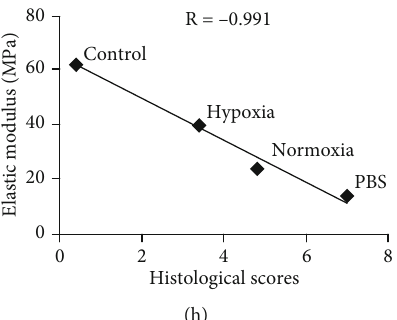
Figure 7: Ultrastructure and biomechanical analysis of specimen at 4 weeks after surgery. Representative images of transmission electron microscopy and the distribution of collagen fi bril diameters (a) and the average diameter of collagen fi brils (b) in the PBS group, the normoxia group, the hypoxia group, and the control (normal) group. Scale bar = 200 nm. Magni fi cation: × 15000. (c – g) Biomechanical analysis for maximum load to failure (c), sti ff ness at failure (d), maximum stress (e), cross-sectional area (f), and elastic modulus (g) in the PBS group, the normoxia group, the hypoxia group, and the control (normal) group. (h) Regression analysis of the relationship between histological scores and elastic modulus. The points represented the mean of each group. Data were shown as mean ± SD . ★ p < 0 : 05 ; ★★ p < 0 : 01